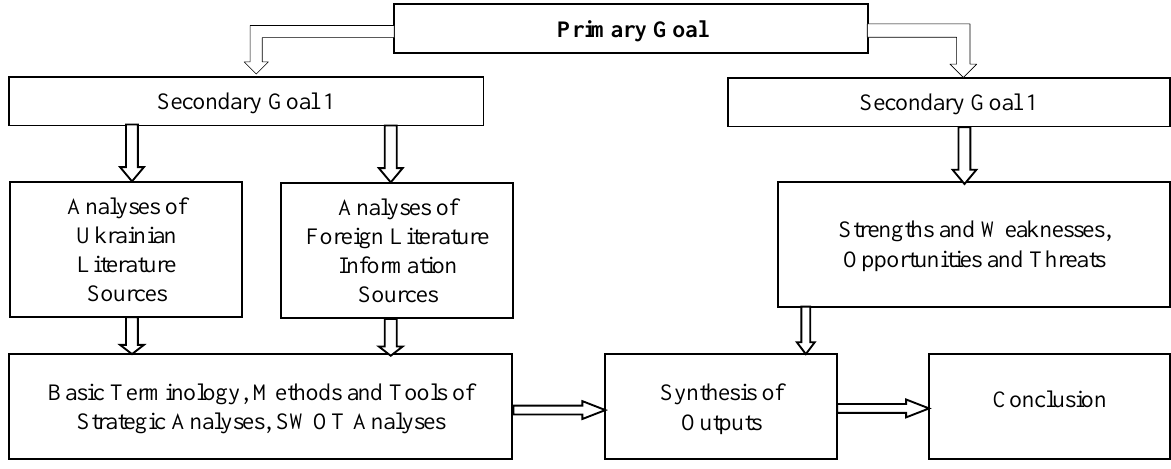
Figure 1. Flowchart of the research methodology.